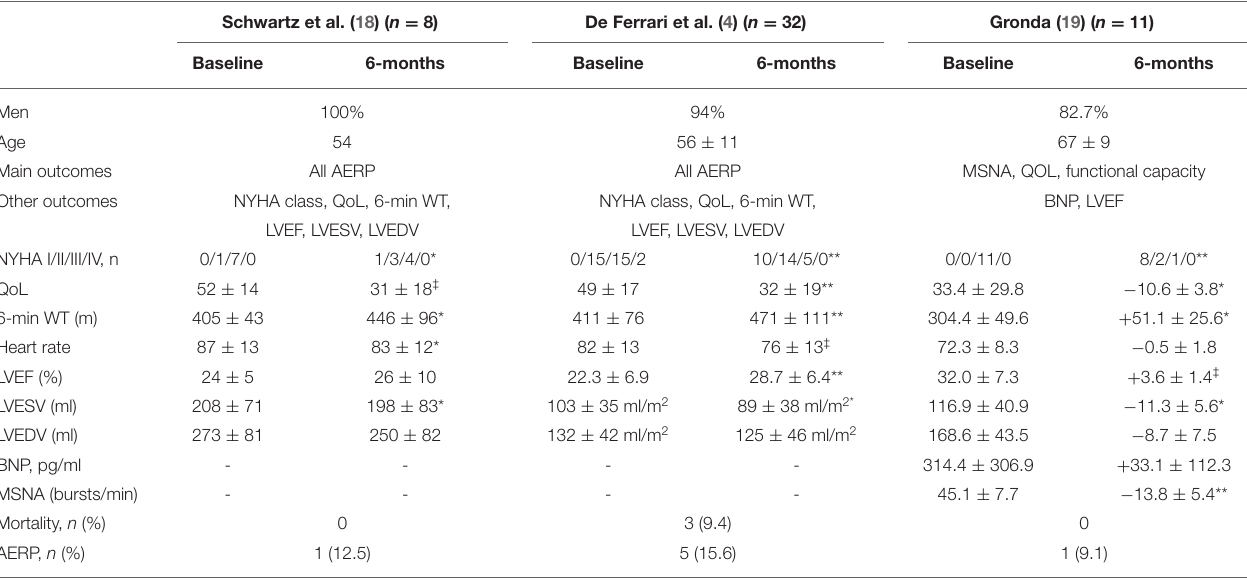
TABLE 5 | Prospective studies before and after vagus nerve